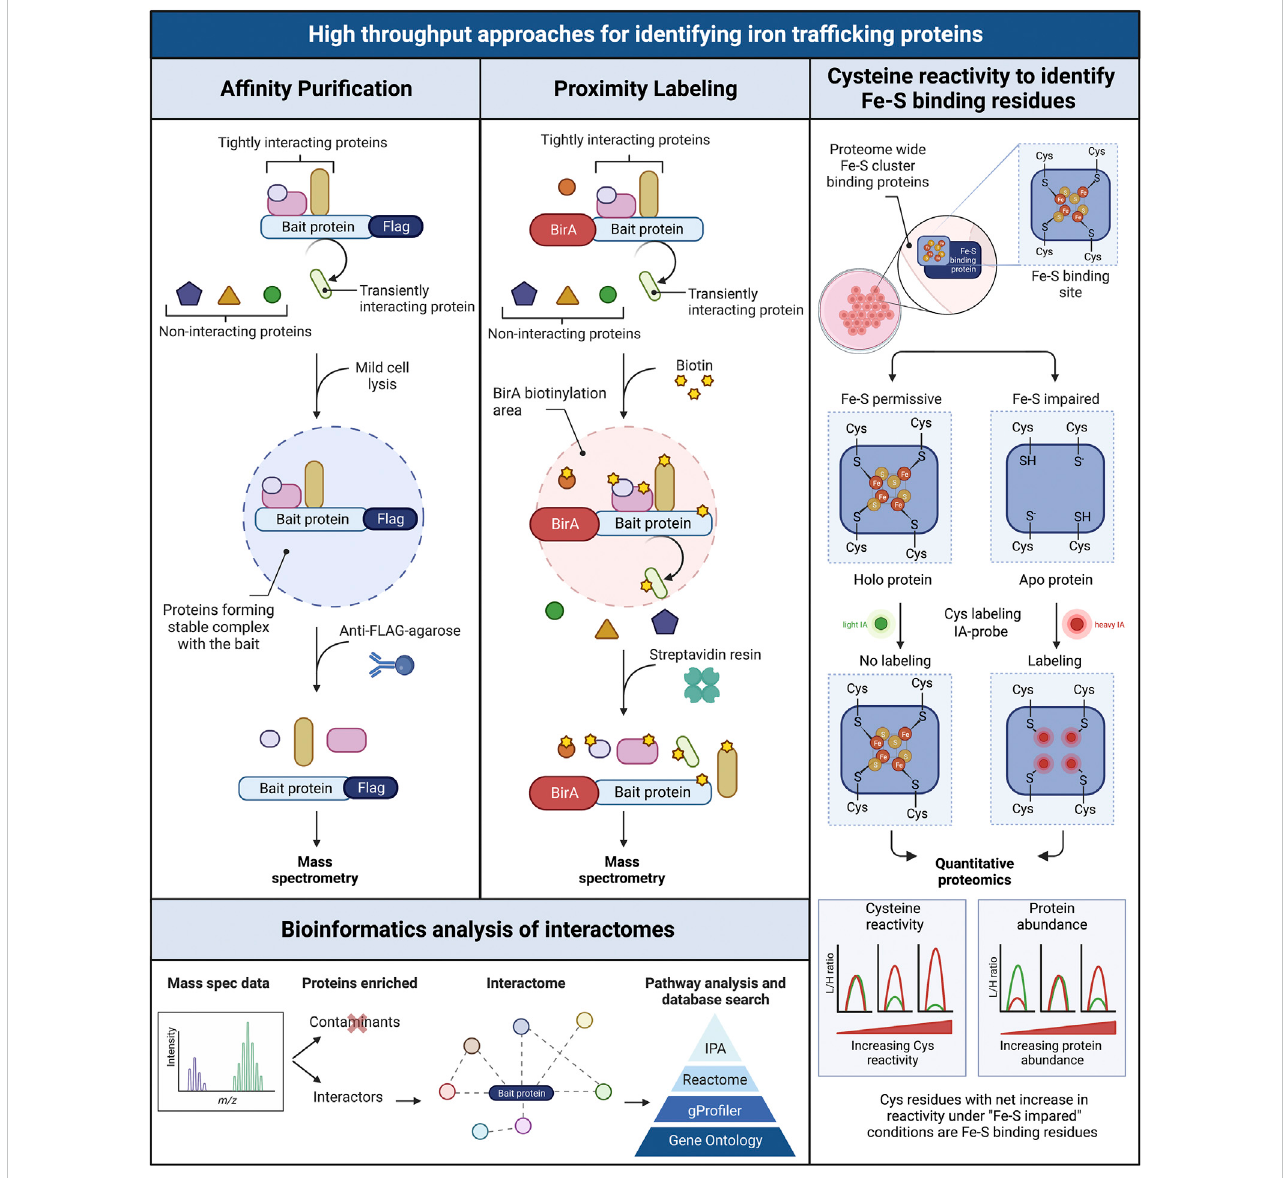
FIGURE 5 Schematic overview of three high throughput work fl ows for screening interacting intracellular iron traf fi cking proteins. Af fi nity puri fi cation (left panel): the fl ag tagged bait protein is pulled down from cell lysates (mild conditions) using an anti-Flag agarose resin. Only tightly interacting proteins forming stable complexeswiththebaitarecoimmunoprecipitated.Interactingproteinsareidenti fi ed via massspectrometry. ProximitylabelingBioID(centralpanel):thebait protein is expressed fused to the biotin ligase BirA, which biotinylates proteins located in close proximity to the bait, including tightly and transiently interacting proteins. Biotinylated proteins are puri fi ed using streptavidin resin and identi fi ed via mass spectrometry. Bioinformatics analysis of interactomes (bottom left panel): the obtained proteomic data are fi ltered to separate non-speci fi c interactors and contaminants from true interactors. Interactomes are then visualized in networks and analyzed for enriched canonical pathways related to iron traf fi cking and metabolism. Cysteine reactivity to identify Fe-S binding residues in proteomes (right panel): Cysteines in Fe-S cluster binding sites of proteins are analyzed proteome-wide under Fe-S permissive (control conditionsthatfavortheformationofFe-Sclusters)andFe-Simpairedconditions(i.e.treatmentwithironchelatororperturbationofFe-Sbiogenesispathway to impair Fe-S cluster formation). The existence of holo or apo forms of the Fe-S proteins is tested by isotopically labeling free cysteines using light (L) and heavy (H) iodoacetamide (IA), one per condition. The presence of the cluster in holo proteins protects the cysteines from IA-alkylation ( No labeling ). In turn, the Fe-S binding cysteines in apo proteins are available for IA-alkylation ( Labeling ). The L/H ratio is determined via quantitative proteomics to measure the reactivity of the cysteines in the Fe-S proteins. A parallel proteomic quanti fi cation accounts for any change in protein abundance between treatments. Net increases in cysteine reactivity under “ Fe-S ” impaired conditions compared to control, are indicative of the loss of Fe-S clusters. Figured adapted from